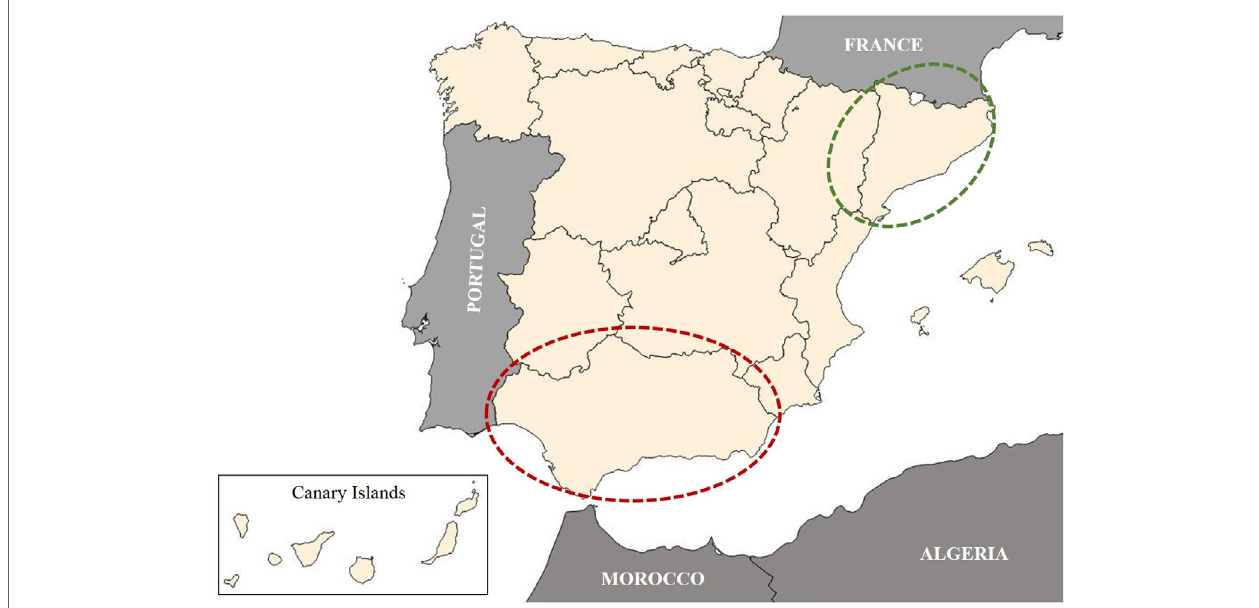
FigUre 1 | Map of Spain by Autonomous Communities is shown in the figure. Dotted ellipses indicate the two study areas. Red dotted ellipses: Andalusia, high prevalence area. Green dotted ellipses: Catalonia, low prevalence area. The Canary Islands, an Autonomous Community of Spain located in the Atlantic Ocean (west of Morocco), are illustrated in box at the bottom-left corner of the